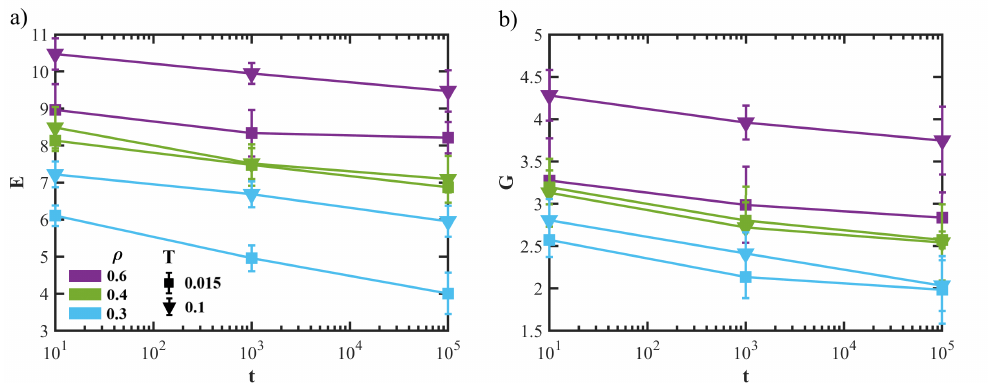
Figure 4. ( a ) Evolution of the elastic constant, Young’s modulus E (panel a ) and shear modulus G (panel b ), with the system’s age for different state parameters (density and quench